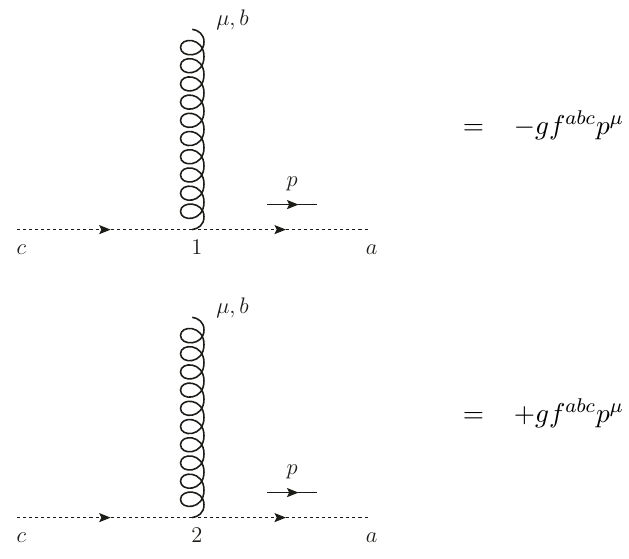
Figure 13. Feynman rules associated to the gauge boson-ghost-ghost vertex, given here for the time-ordered and anti-time ordered branches of the Schwinger-Keldysh contour. The anti-time ordered branch multiplies the vertex factors by ( − 1) , which is naturally included in the notation we adopt in the main